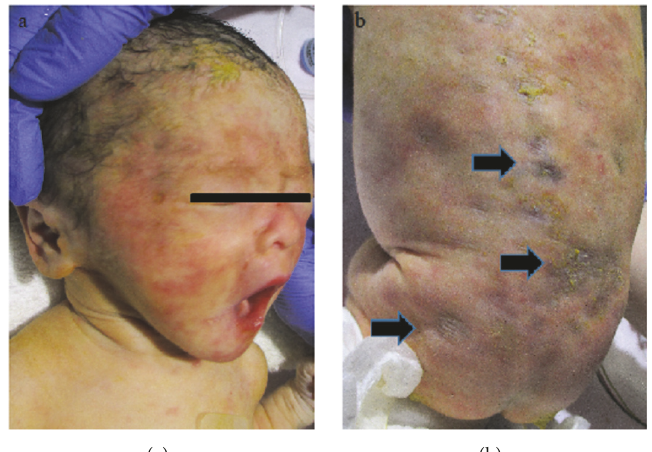
Figure 1: Skin lesions. (a) Skin rash with annular erythematous lesions on the face. (b) Annular, erythematous, scaly, atrophic patches on the trunk and back